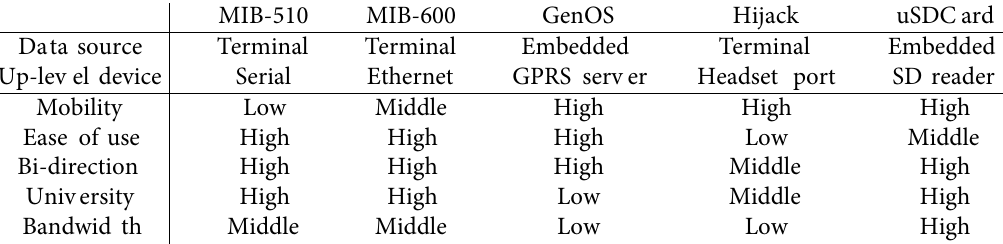
Table 1. Comparison of the hardware